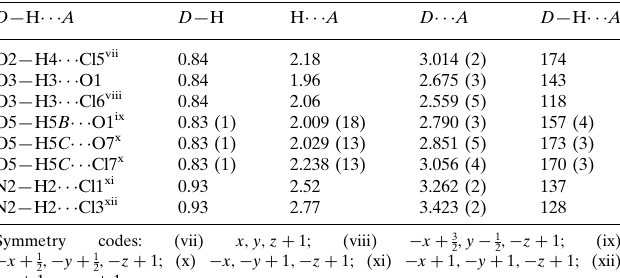
Hydrogen-bond geometry (A˚ , (cid:3)